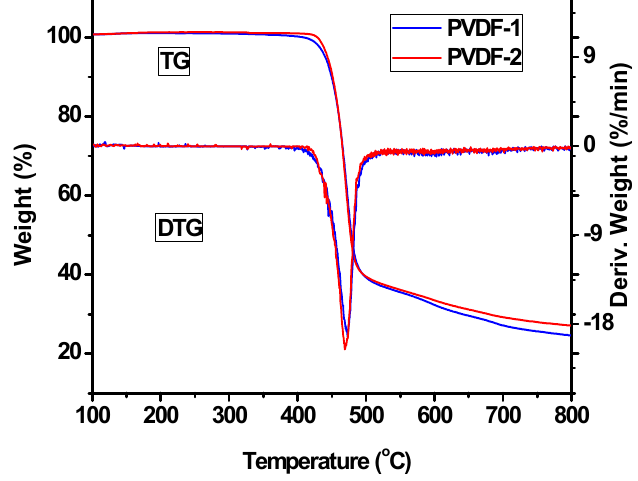
Figure 6. TG and DTG curves of the electrospun PVDF membranes.